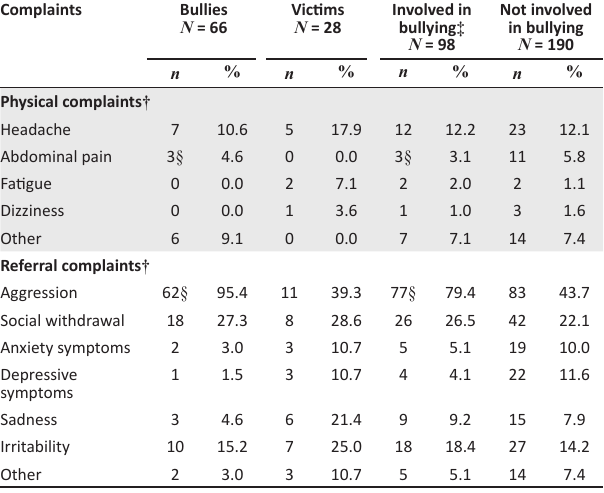
TABLE 3: Clinical diagnoses of children involved and not involved in bullying. Clinical diagnoses † Bullies N = 66